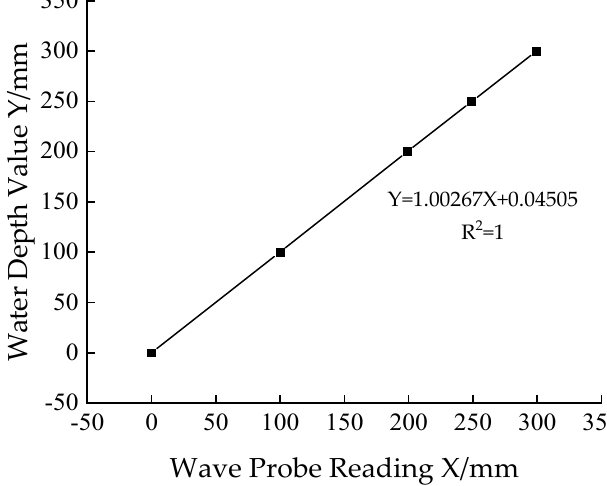
Figure 4. Fitting curve of wave probe calibration.